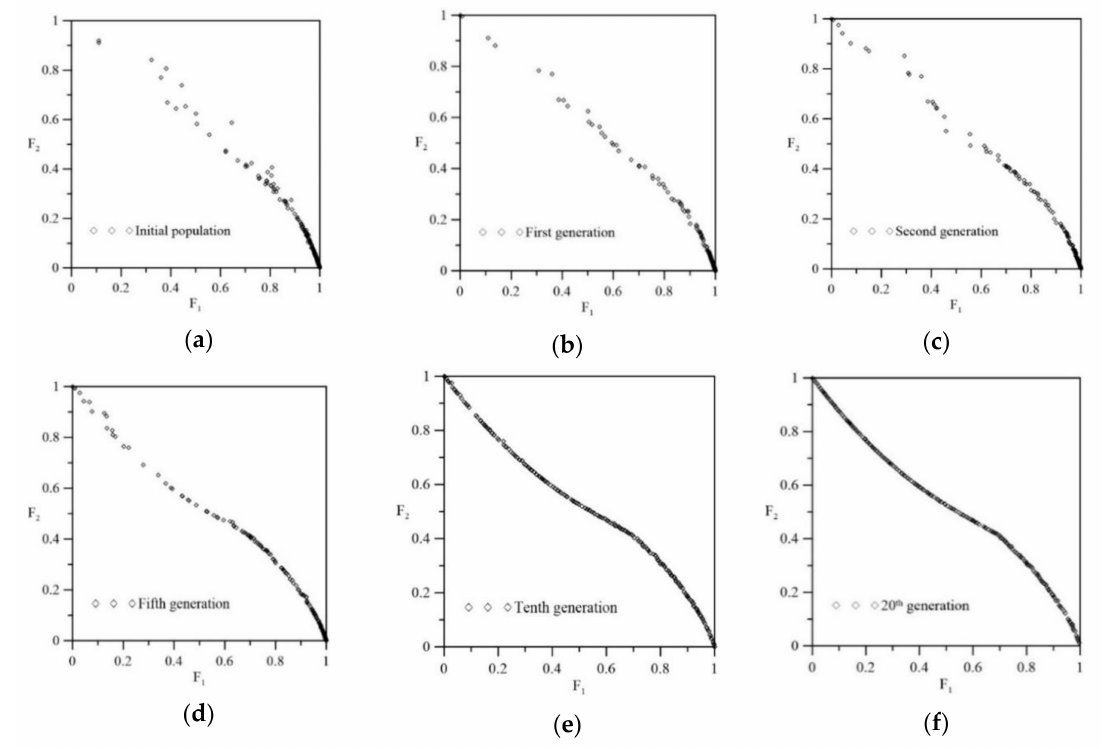
Figure 7. Two hundred populations for different generations shown in the objective spaces, in which the temperature- independent (TI) material properties are considered; ( a ) initial generation; ( b ) 1st generation; ( c ) 2nd generation; ( d ) 5th generation; ( e ) 10th generation; ( f ) 20th generation.